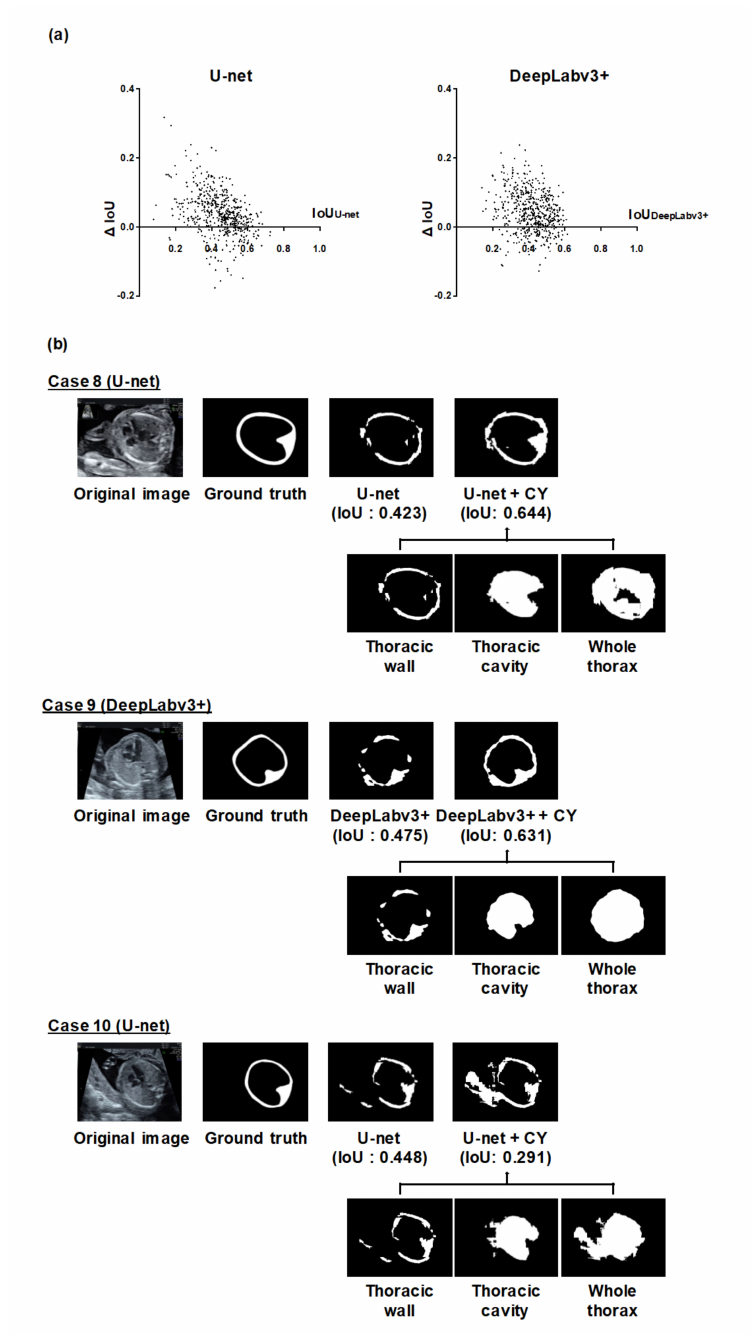
Figure 4. Analysis of the thoracic wall segmentation in the IoU metric using CY. ( a ) The di ff erences of the IoU values in all individual images using U-net or DeepLabv3 + and CY. We calculated the IoU of U-net or DeepLabv3 + (IoUU-net or IoUDeepLabv3 + ), the IoU of CY (IoUCY), and the di ff erence for the IoU values between them ( ∆ IoU = IoUCY − IoUU-net or IoUDeepLabv3 + ). CNN models were based on U-net and DeepLabv3 + . The x-axis represents the IoUU-net or IoUDeepLabv3 + , and the y-axis represents ∆ IoU. ( b ) Representative examples of the thoracic wall segmentation using CY. CNN models were based on U-net (case 8, 10) and DeepLabv3 + (case 9). The upper row of each case presents the prediction labels obtained from the U-net or DeepLabv3 + alone and CY. The lower row shows the prediction labels of the neighboring frames integrated by CY. In case 8 and 9, the segmentation performance was improved by CY. On the other hand, in case 10, the segmentation performance worsened by